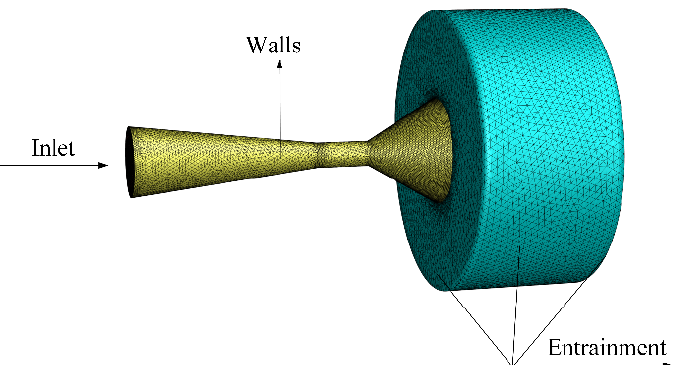
Figure 4. Mesh of calculation domain.